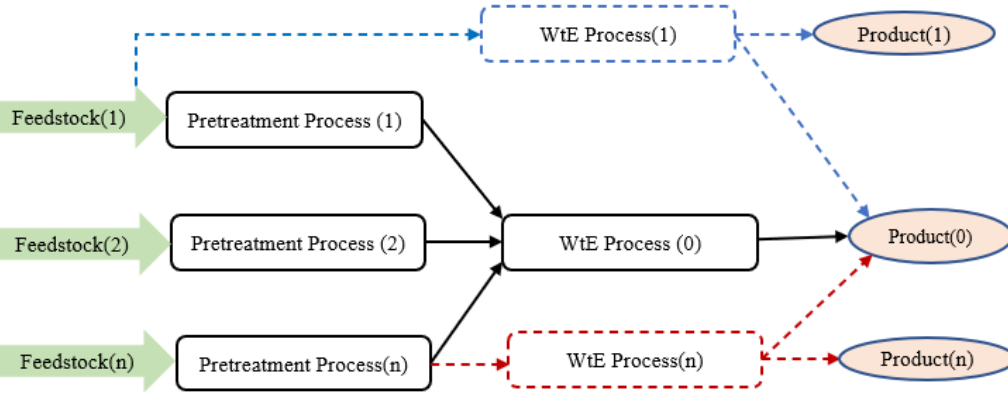
Figure 7 . Illustration of the possible biorefinery integration by feedstocks .